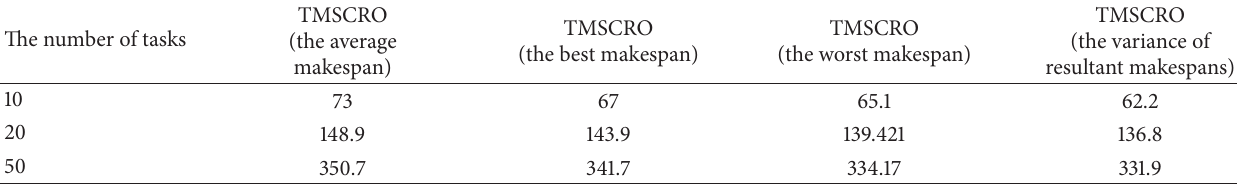
Table 11: The experiment results for the random graph under different task numbers, CCR = 10; the number of processors is 32. The number of tasks